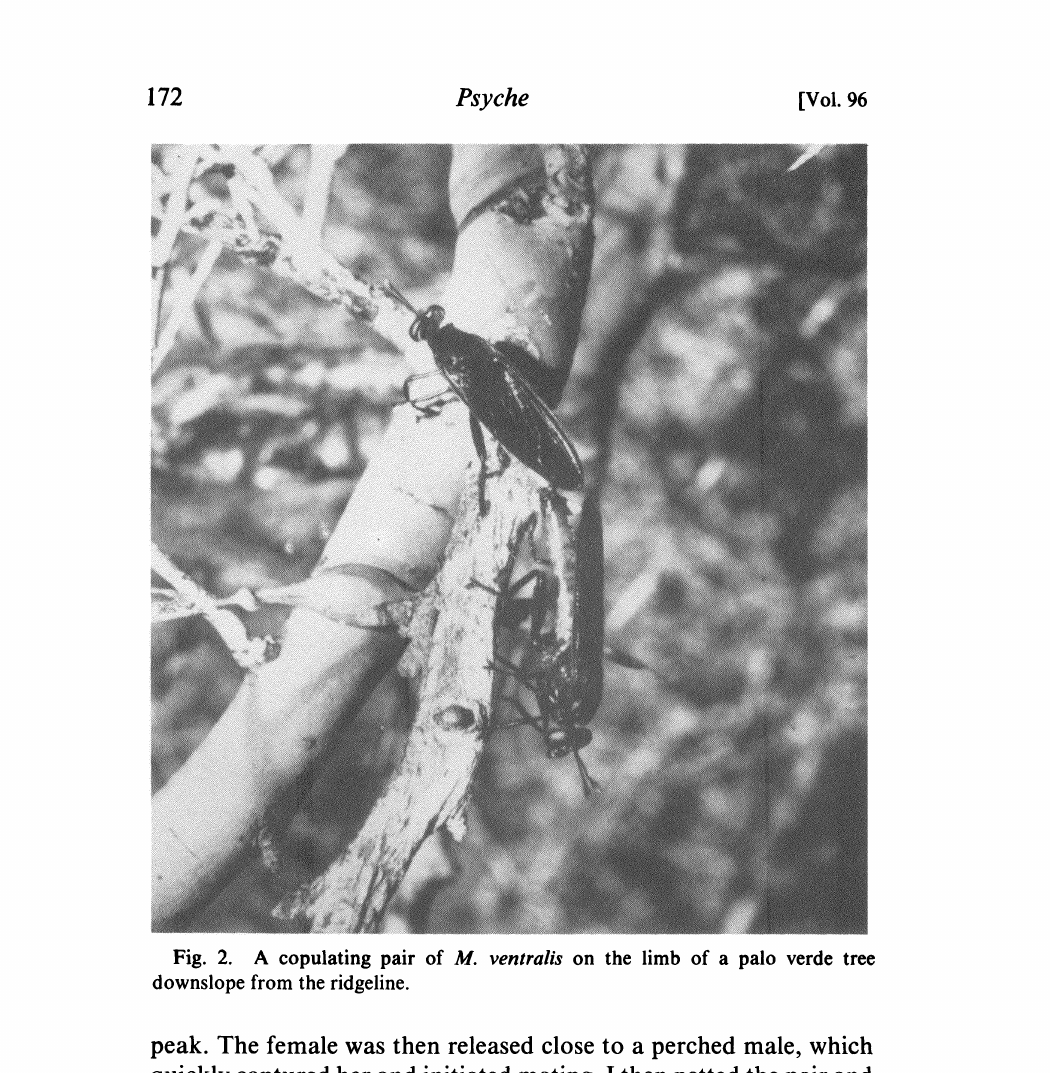
Fig. 2. A copulating pair of M. ventralis on the limb of a palo verde tree downslope from the